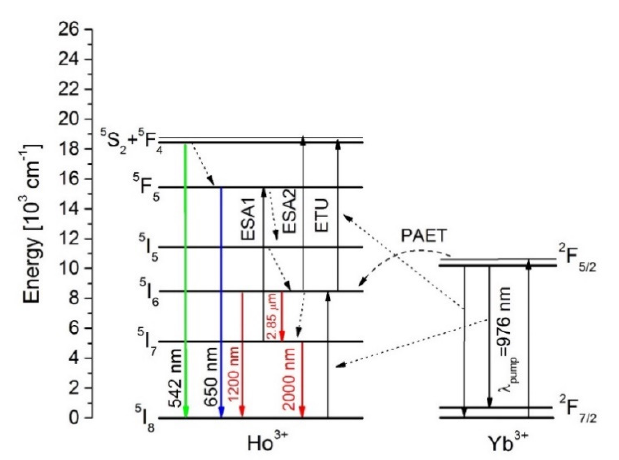
Figure 5. Simplified energy level diagram of Yb 3+ /Ho 3+ co-doped fluoroindate glass. The energy transfer mechanisms under excitation at 976 nm are also indicated.